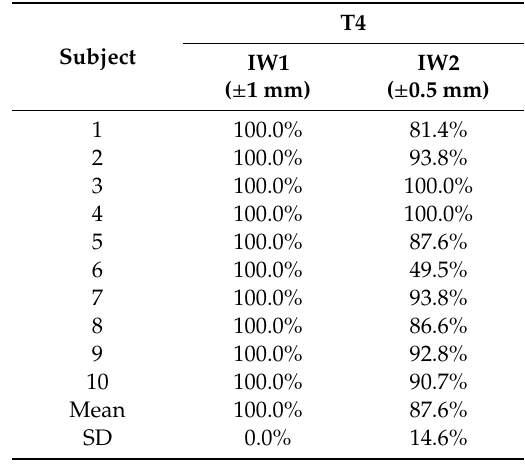
IW = inspection window; SD = standard deviation.